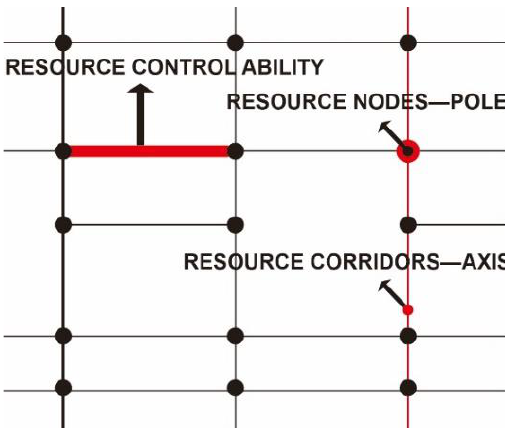
Figure 1. Basic elements of a network model.